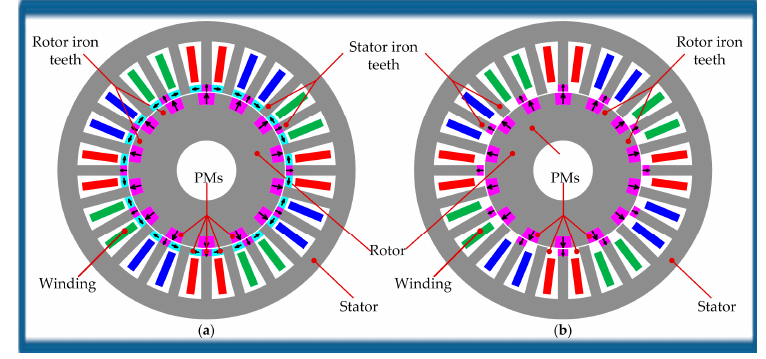
Figure 15. DPME Machines for comparison: ( a ) Proposed machine; and, ( b ) Machine I.